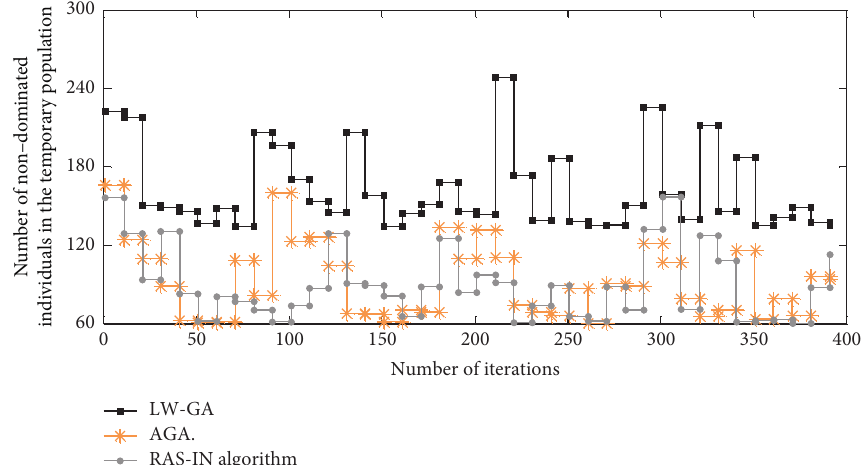
Figure 8: The number of nondominated individuals in the temporary population under different iteration times.